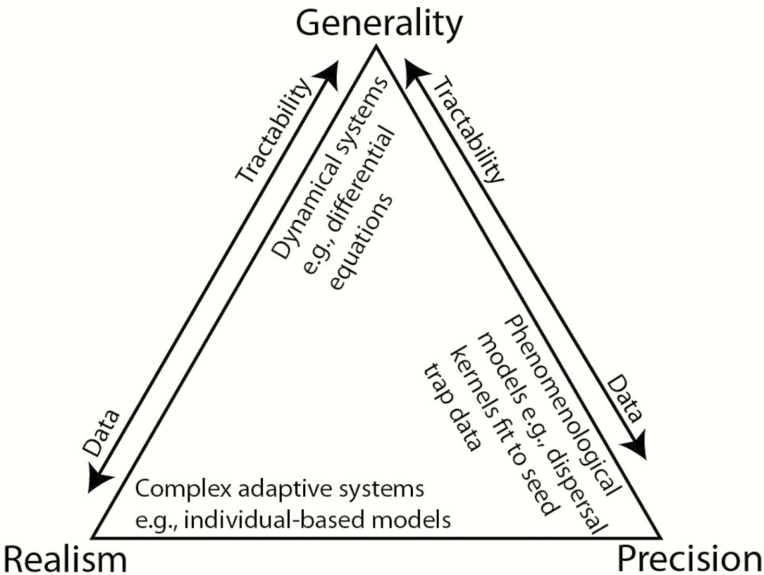
Trade-offs in model building as discussed by Levins (1966): the goals of models are to maximize generality, realism and precision but trade-offs exist such that only two of these three goals can be captured. While there is philosophical doubt on whether these trade-offs exist (Evans 2012), maximizing all three goals will likely result in a model that is intractable and impossible to analyse (Silverman 2018).